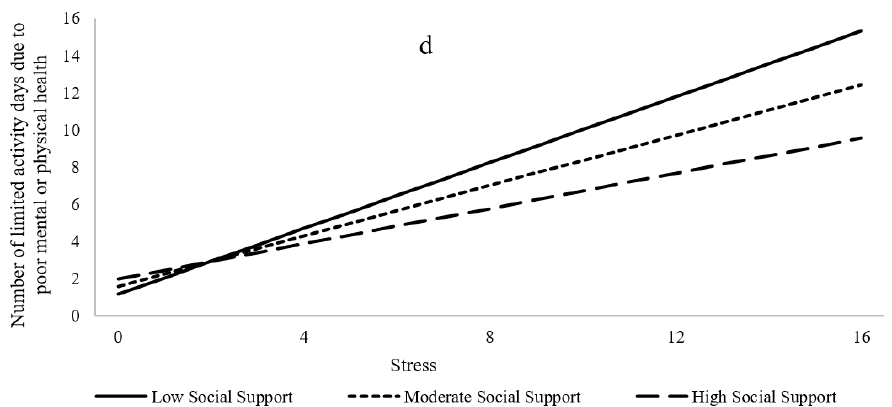
Figure 2. Moderating effect of social support on the association between stress and health-related quality of life among adults experiencing homelessness ( N = 581). Covariates were age, sex, race, education, health insurance status, lifetime homelessness, a history of serious mental illness, and recruitment site. ( a ) shows moderation of social support in the association between stress and self- rated health. ( b ) shows moderation of social support in the association between stress and number of days of poor physical health. ( c ) shows moderation of social support in the association between stress and number of days of poor mental health. ( d ) shows moderation of social support in the association between stress and number of activity-limited days due to poor physical or mental health.